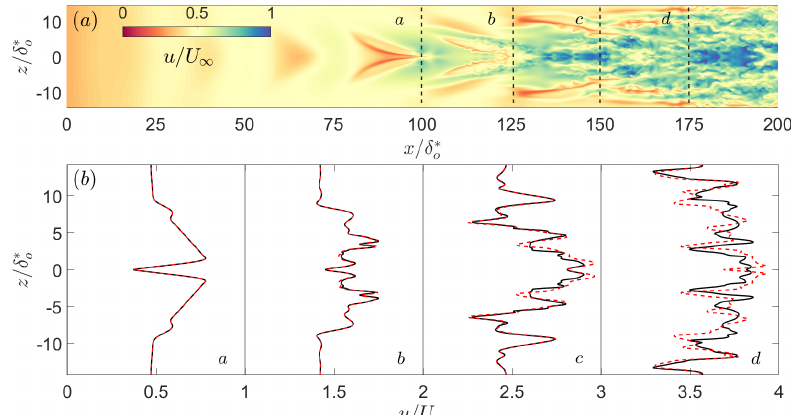
Figure 14. Small step. Instantaneous streamwise velocity in the y wall / δ ∗ o = 1.0 plane. ( a ) Velocity contours; ( b ) velocity profiles at the locations indicated by dashed lines in ( a ). t = t o ; t = t o + T .